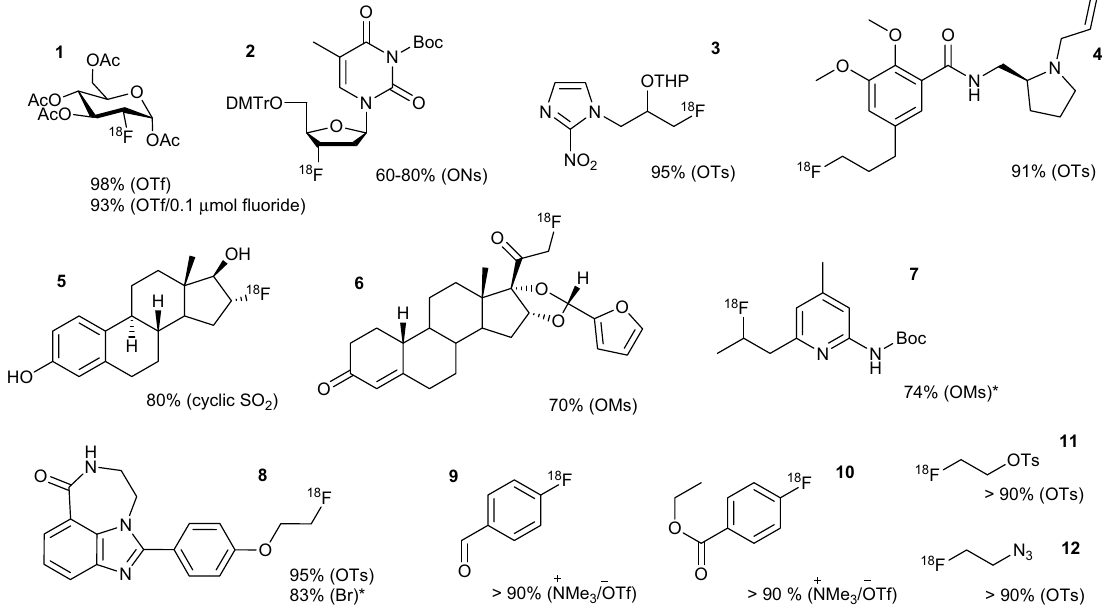
Figure 4. Exploration of nucleophilic radiofluorination using [ 18 F]TsF and other sulfonyl fluorides (indicated by *). Radiochemical conversion (RCC) was determined by radio-TLC and the leaving group is indicated in the parentheses. The reaction details of each compound are presented in supplementary Table